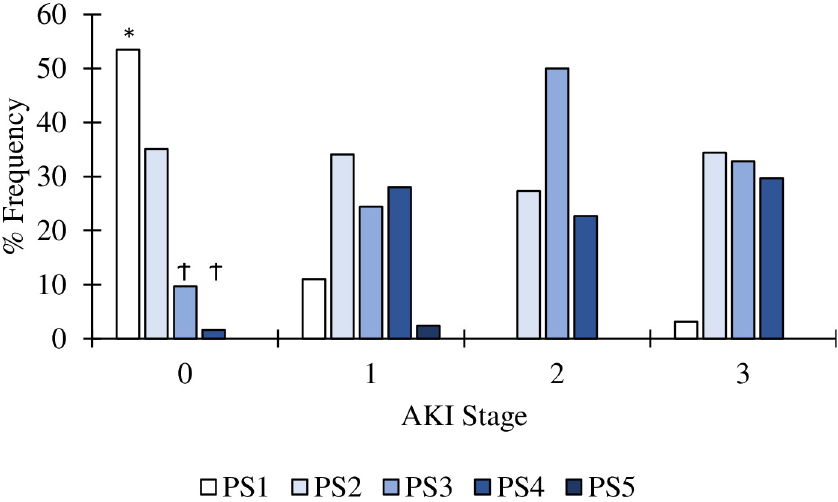
Fig 2. The frequency of non-AKI and different stages of AKI patients who had pneumonia and categorized according to a PSI. PSI 1 in non-AKI patients were significantly higher ( � p < 0.001) than all patients who developed AKI, regardless of the stage. Furthermore, in non-AKI patients PSI 3 and 4 were significantly ( Ϯ p < 0.001) less than in any stage of AKI patients.